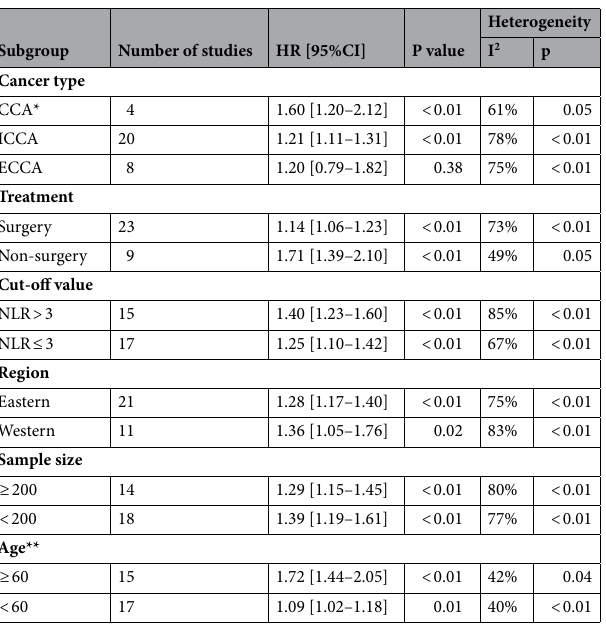
Table 3. Summary of the subgroup analyses of the correlation between NLR and overall survival in CCA patients. *Includes both ICCA and ECCA. **Mean/median age of the study cohort. ECCA extrahepatic cholangiocarcinoma, HR hazard ratio, ICCA intrahepatic cholangiocarcinoma, NLR neutrophil-to-lymphocyte ratio.